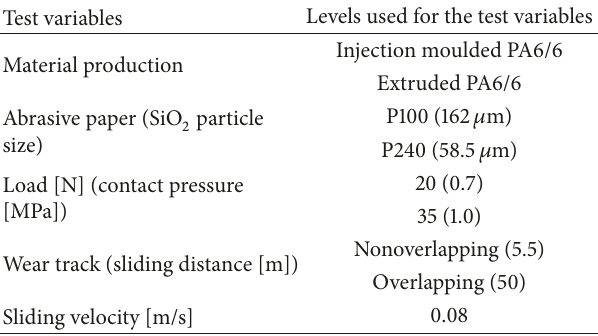
Table 2: Wear test